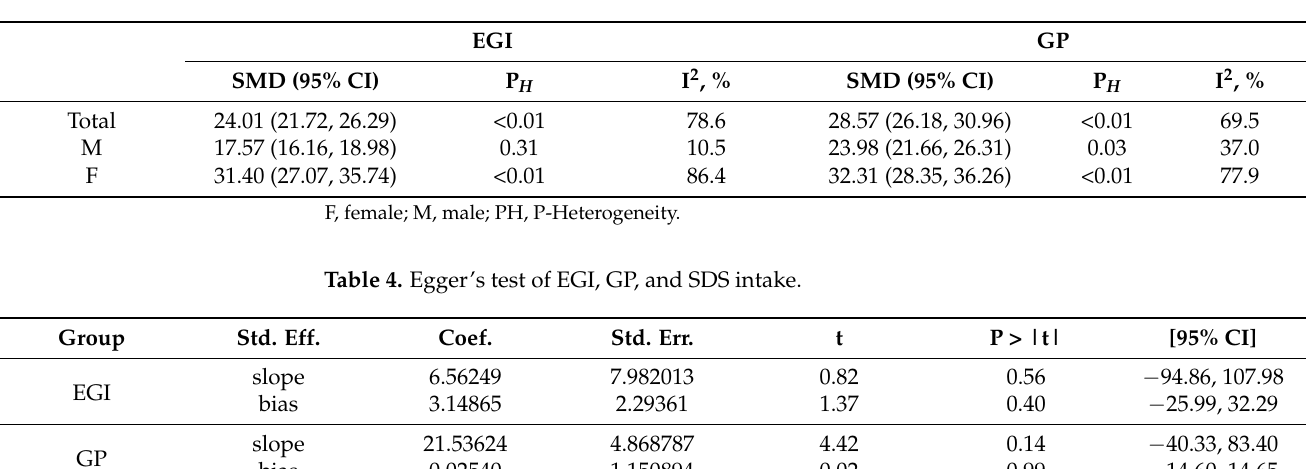
Table 3. Subgroup analyses of SDS intake and EGI, GP.